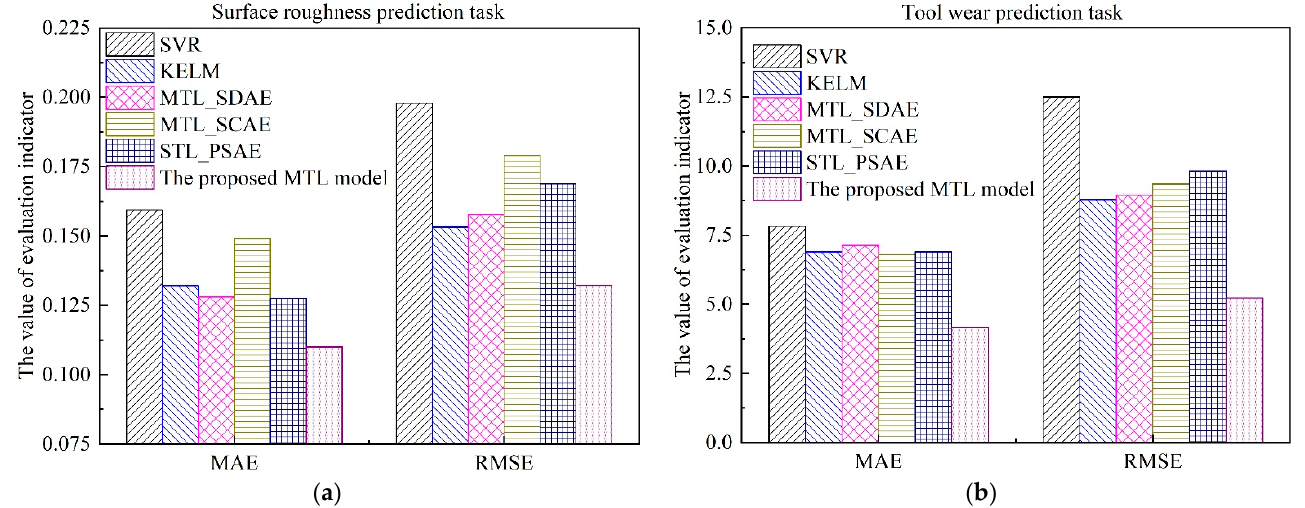
Figure 17. Performance comparison of different models. ( a ) Surface roughness; ( b ) Tool wear.